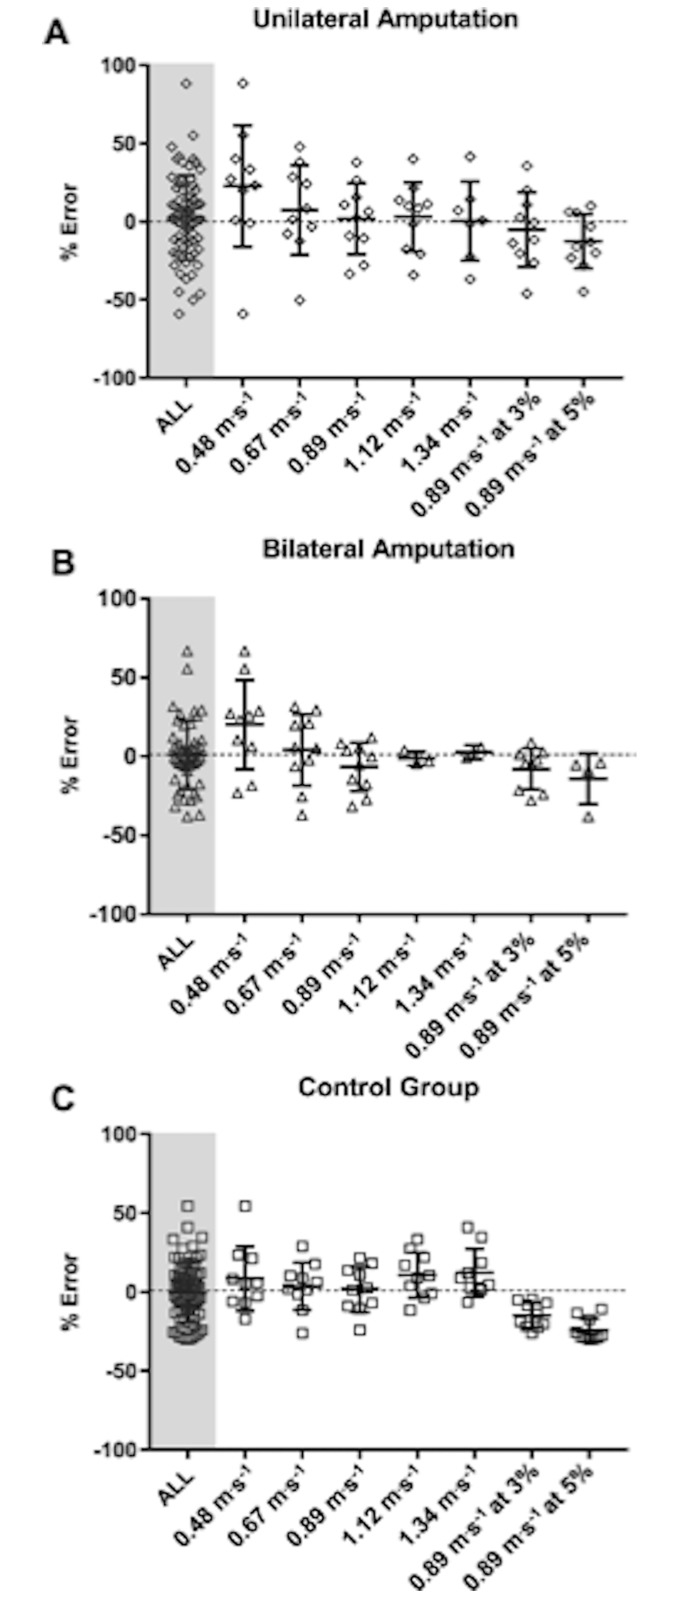
Modified box and whisker plots demonstrating the mean percentage error of estimation relative to criterion for each treadmill activity using the cross validated, population specific prediction models (Model 2).The plots show the unilateral group (A), bilateral group (B) and control group (C).